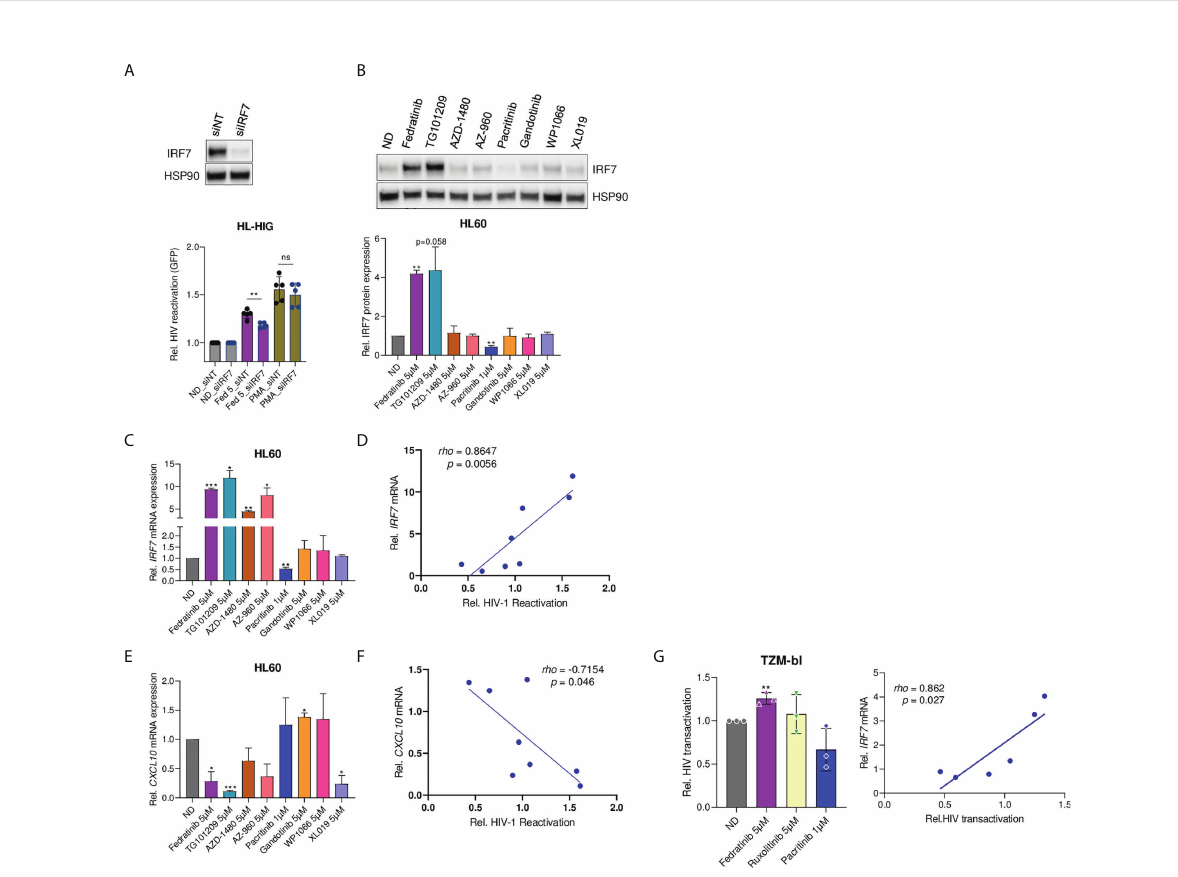
FIGURE 5 Modulation of IRF7 expression correlates with latency reversal capacity. (A) Effect of IRF7 siRNA knockdown on latency reactivation capacity of LRAs. IRF7 knockdown was con fi rmed by western blot (pictograph). Bar plots represent relative HIV-1 reactivation of IRF7 knockdown (siIRF7) and non-targeting (siNT) control cells, treated or not with fedratinib at 5 µM or PMA at 0.1µg/ml. (B) IRF7 protein expression in HL60 cells treated with the distinct JAK2i. A representative experiment is shown. Bar plots represent the mean quanti fi cation of bands obtained by densitometry analysis of 3 independent experiments. Values were normalized to that of Hsp90 used as a loading control and relativized to the untreated condition (ND). (C-E) Gene expression of IRF7 and CXCL10 in JAK2i -treated HL-60 cells. Relative mRNA expressions are expressed as fold-change differences in expression of gene-of-interest relative to GAPDH gene. (D, F) Correlation plots of IRF7 and CXCL10 gene expression (C, D) versus HIV-1 latency reversal capacity of JAK2i-treated cells. (G) Fedratinib induces Tat-dependent viral expression of HIV-1 LTR promoter and correlated with IRF7 expression. HeLa TZM-bl cells were transfected with Tat-expressing plasmid for 24h. HIV-1 transactivation was measured by a luciferase-based assay 20 hours post treatment with compounds. Left panel, relative Tat-induced HIV-1 transactivation upon JAK2i treatment. Right panel, correlation between HIV-1 transactivation and IRF7 expression (see also Figure S5F). Values were normalized to the untreated control. Data are expressed as mean ± SD of at least three independent experiments. ∗ p<0.05; ∗∗ p<0.01; ∗∗∗ p<0.001. not signi fi cant (ns) for